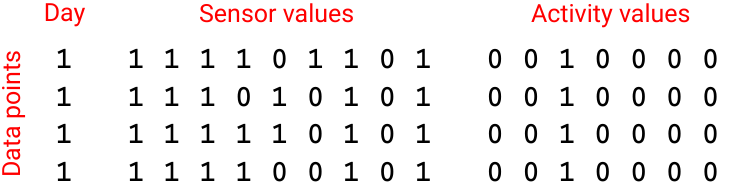
Figure 2. Excerpt from the preprocessed dataset. The first column denotes the day in the dataset, the following columns denote sensor values (one column per sensor), and the last columns denote activity values (one column per activity). Each line represents one data point and corresponds to one time slot. Value 1 denotes active sensor or present